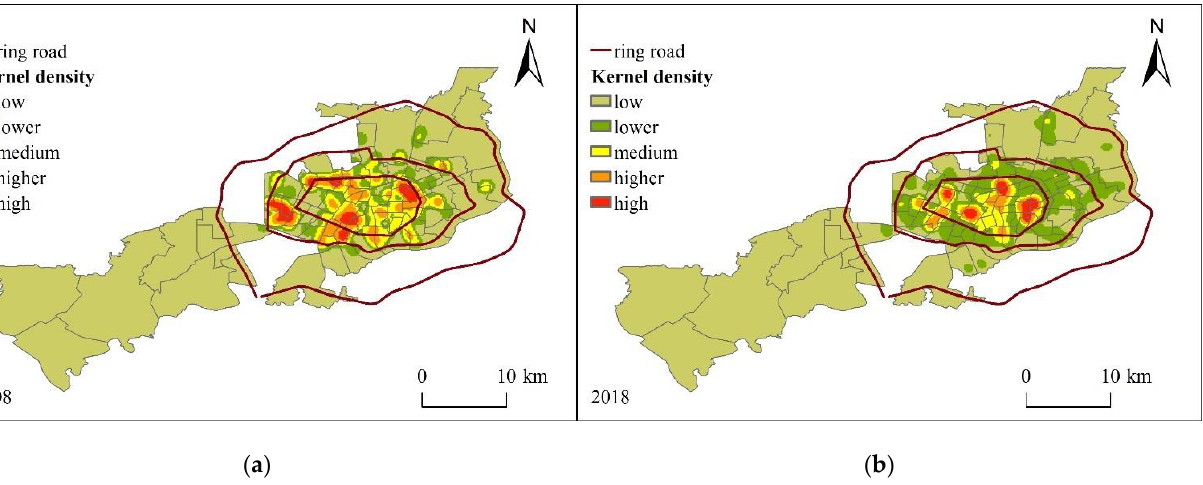
Figure 6. Kernel density of public toilets in Shenyang: ( a ) distribution of Kernel density in 2008; ( b ) distribution of Kernel density in 2018.